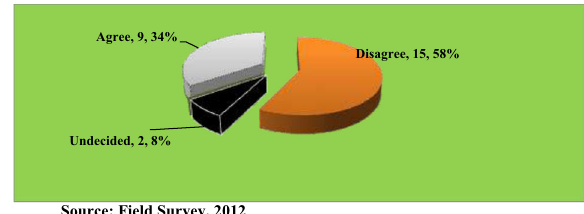
Fig. 4 The respondents' preference on who to liaise with in the Host Community. Responses on the question – It is better to liaise with the community chiefs than liaising with